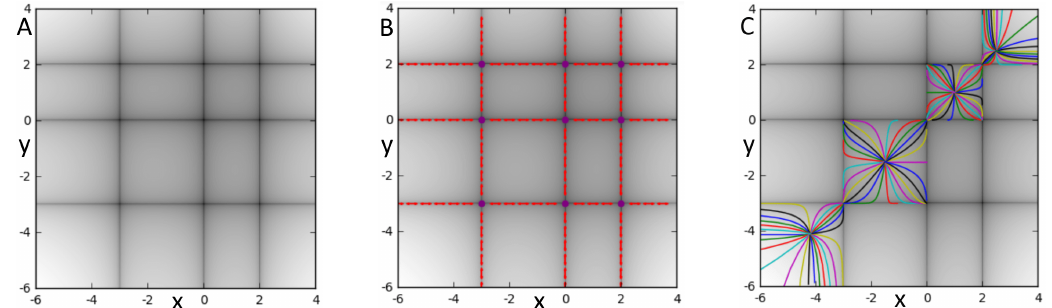
Figure 11: Geodesic trajectories in the xy-factored model. We use a manifold with ( x ) = p ( x ) , v 2 ( y ) = p ( y ) with p ( x ) = x 3 + x 2 − 6 x , creating curvature singularities v 1 2 1 along the lines { x = − 3, x = 0, x = 2, y = − 3, y = 0, y = 2 } . A: Heat map of the time-dilation factor γ [ Eq. (25) ] , depicting curvature singularities along vertical and horizontal walls. B: Heat map annotated to mark the collimation angles of the nematic singularities and the locations of isotropic singularities. C: Heat map with geodesic trajectories superimposed. Note that the geodesics are trapped in the box in which they start and asymptote towards isotropic singularities at the